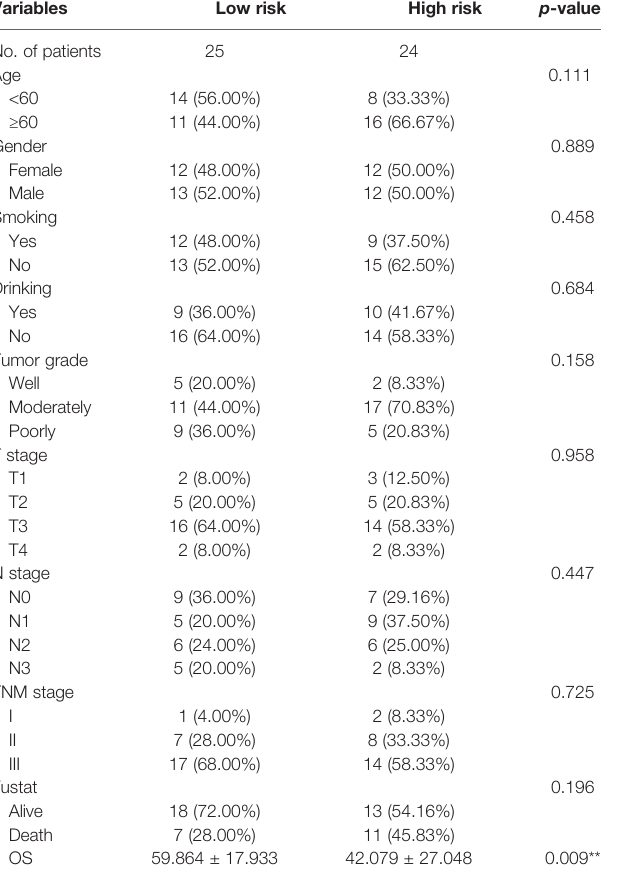
TABLE 2 | The clinical characteristics at baseline, strati fi ed by risk score in IHC validation group. Variable Low